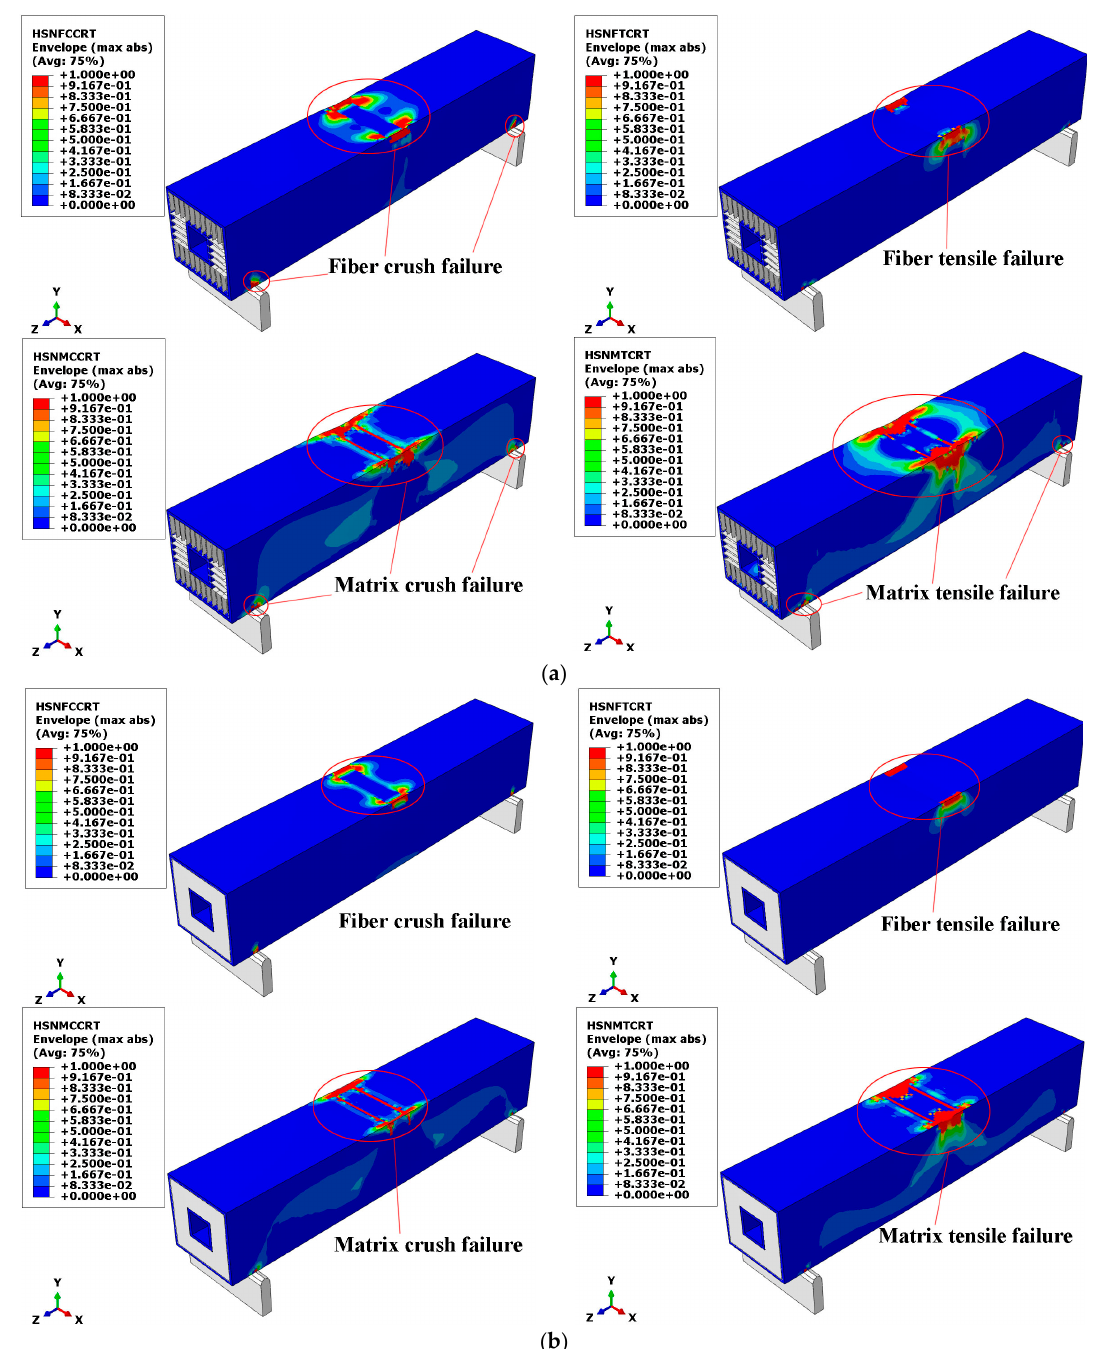
Figure 16. Failure modes of composite sandwich laminated box beam. ( a ) Aluminum honeycomb core; ( b ) Aluminum foam core.